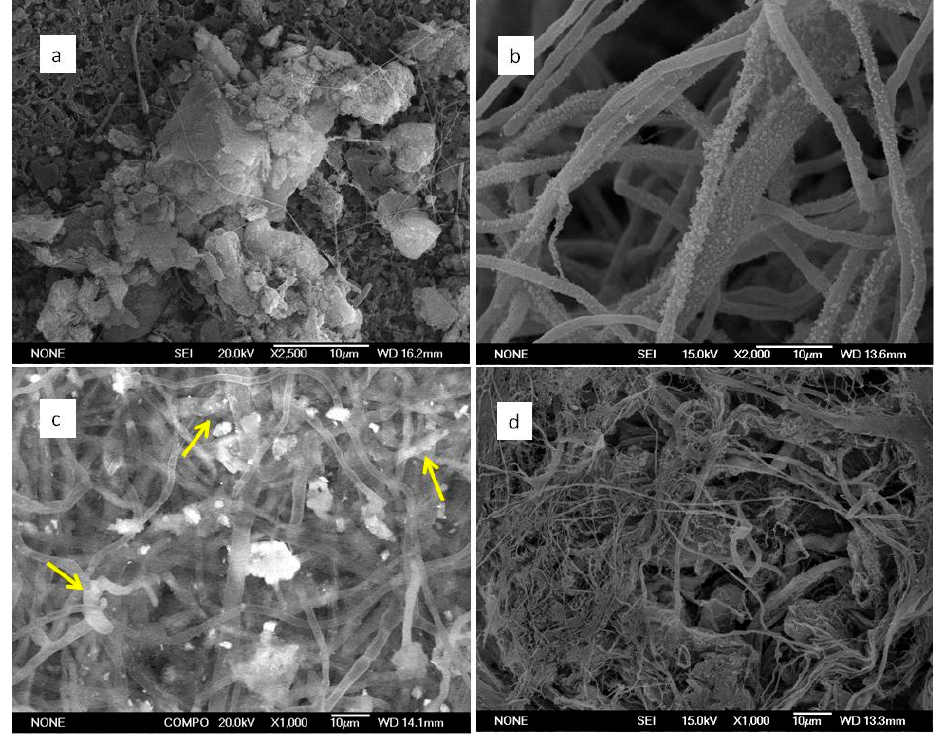
Figure 8. SEM images of ( a ) monazite particles after 24 h under fungal bioleaching, ( b ) mycelium developed after 14 days of fungal growth. ( c ) Backscattered electron SEM micrograph of A. niger mycelium. Arrows indicated bright areas on the mycelium due to REE deposition. ( d ) SEM image of mycelium encapsulating monazite mineral after 14 days of fungal growth in minimal medium.